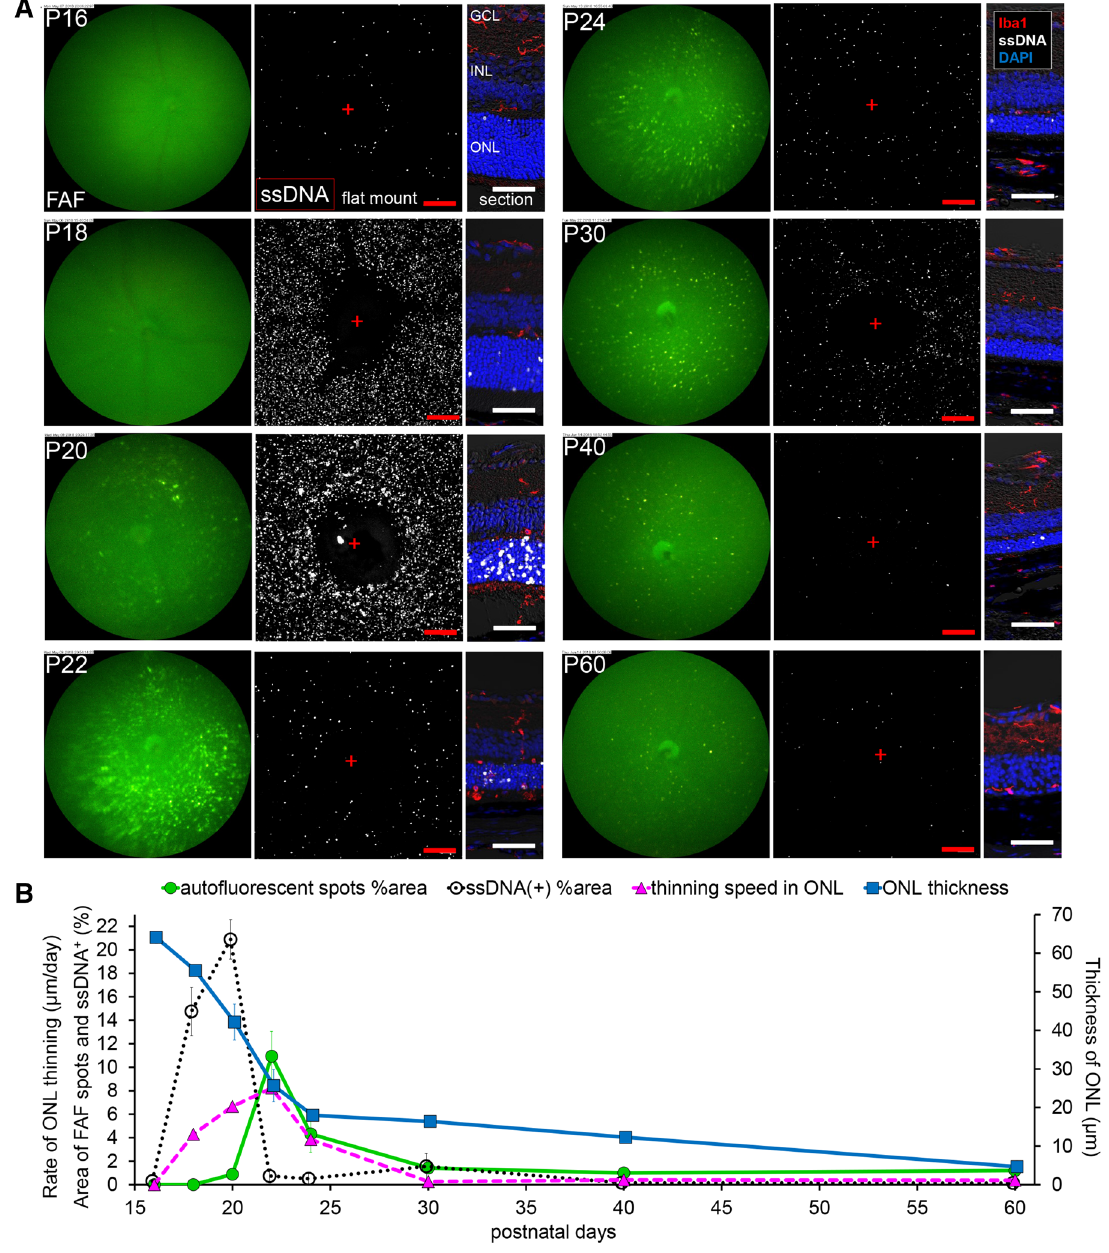
Figure 2. Relationship in fundus autofluorescent spots, apoptosis of photoreceptors and retinal ONL thickness in the central retina of rd10 raised under regular light cycle . ( A ) Pictures show the time course change in the central retina of rd10 from P16 to P60. Left pictures are in vivo FAF imaging with a retinal imaging microscope. Middle pictures show the confocal images of extracted flat-mounted retina at the ONL level, labeled with an apoptosis marker ssDNA (white). Scale bars, 100 μm, “ + ” show the center of the optic nerve head. Right pictures show the retinal section labeled with DAPI (blue), ssDNA (white) and Iba1 (red). Scale bars, 50 μm. ( B ) The graphs show the quantification of the FAF spot area % (green line), the ssDNA + area % (black line), the thickness of the ONL (blue line) and thinning rate of the ONL (magenta line). The markers of the graph show mean and SD (n = 4). The peak of thinning rate of the ONL and the peak of FAF spot area were observed synchronously on P22 with a slight delay after the peak of